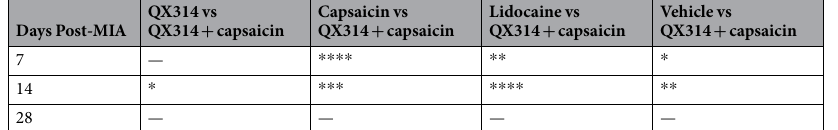
— — — Table 1. The effect of intra-articular pharmacological treatments at days 7, 14 and 28 on WB asymmetry in MIA pre-treated rats. Comparisons between QX-314 + capsaicin treated rats have been made with QX-314, capsaicin, lidocaine and vehicle treated rats. Comparisons were made with a repeated measure 2-way ANVOA with Sidak’s post-test. * p < 0.05, ** p < 0.01, *** p < 0.001, **** p <